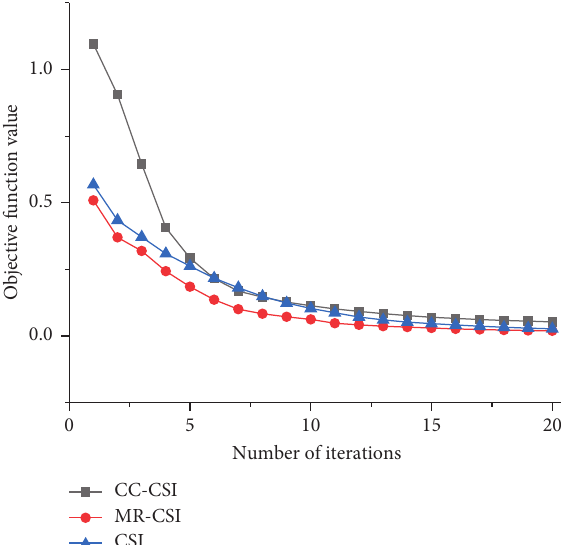
Figure 13: The objective function values of the single scatterer.